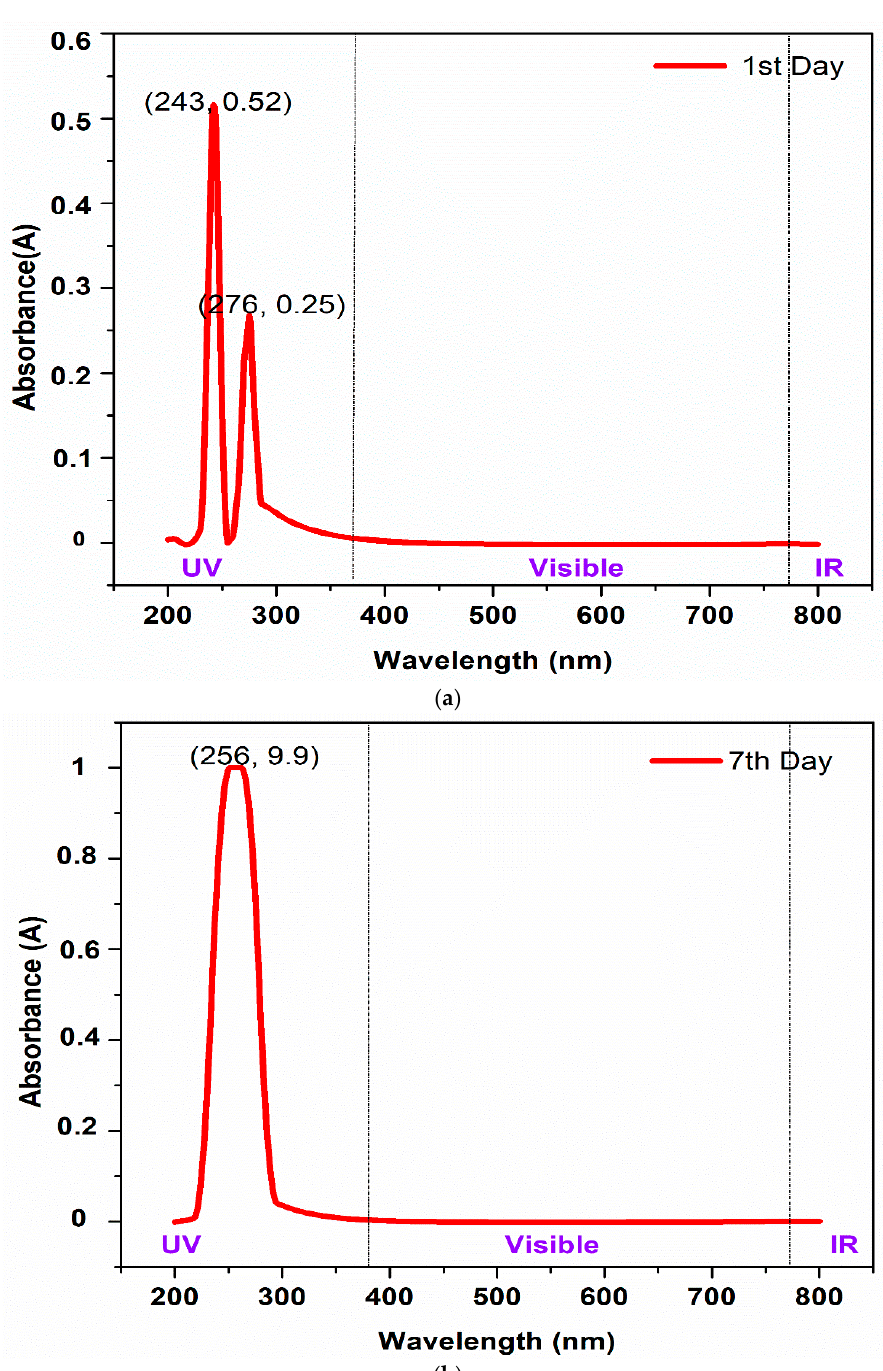
Figure 7. UV-Vis absorbance spectra of the base fluid on the ( a ) first day and ( b ) the seventh day. The tested base fluid spectrum showed the maximum absorbance value at 200 to 300 nm wavelength (UV region), which was in good agreement with previous literature [15]. Depending on the absorption of photons, UV-Vis peaks could be smaller or larger. The absorption of large numbers of photons leads to larger peaks. The peak observed at 243 nm in the UV-Vis spectrum of the base fluid (Figure 7a) attributed to the conjugation of π electron transition ( π – π * transition) from the lowest unoccupied molecular orbital (LUMO) to the highest occupied molecular orbital (HOMO). The